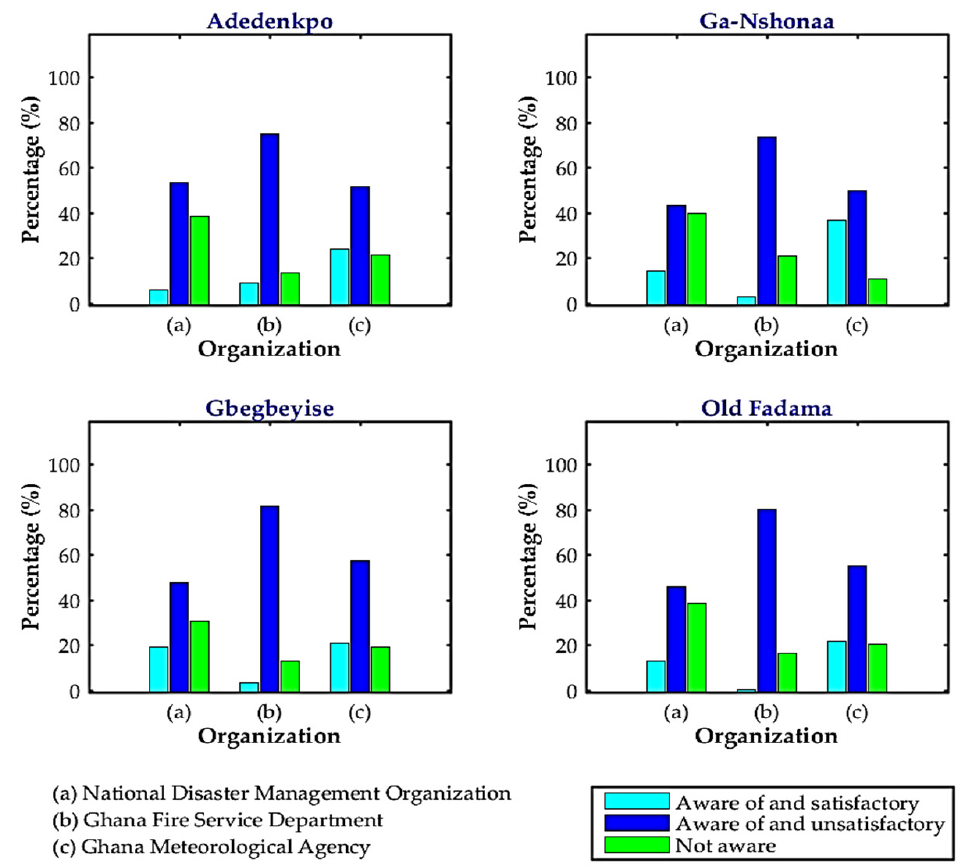
Figure 4. Perceived Presence and Performance of State Disaster Management Institutions. Source: Authors’ construct, based on household survey